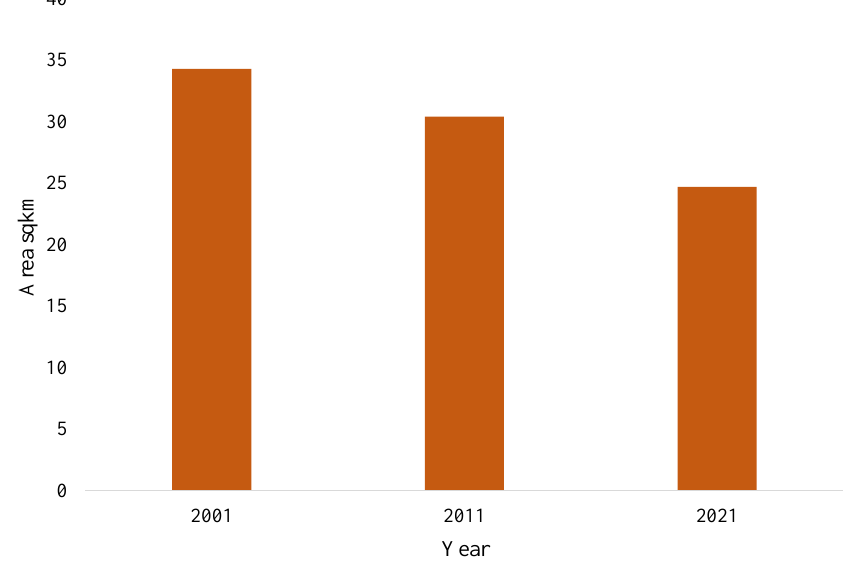
Figure 6. Column graph showing comparative waterbody change for 2001, 2011, and 2021. The Others category includes barren land, open land, wasteland and fallow land. We observed a slight change in the areas under this category. In 2001, it was covered by 888.89 km 2 , and in 2011, it slightly increased to 999.38 km 2 , and it decreased again by an area of 806.96 km 2 . Figure 7 shows the trend change in area under barren land in 20 years. Figure 7. Column graph showing comparative change in Others category for 2001, 2011, and 2021.